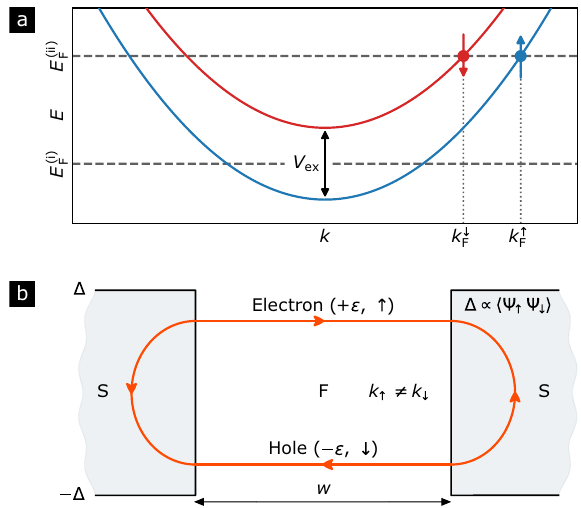
Fig. 2 Bound states in SFS junctions. a Simpli fi ed band structure of a ferromagnet, with the majority and minority bands, split by V ex . k " F and k # are the Fermi momenta for the majority and minority carriers, F respectively. Fermi level E ð i Þ corresponds to large V ex , where the F minority band is pushed above E ð i Þ . E ð ii Þ corresponds to small V ex . F F Thus, the propagation of minority quasiparticles is characterized by and is suppressed. b Supercurrent in an imaginary momentum k # F SFS junction is carried by Andreev bound states localized in the junction. Solid red line represents a quasi-classical trajectory corresponding to an Andreev bound state. The spectrum of Andreev states depends on the relative superconducting phase difference (cid:3) k # j w , across the junction as well as the phase, δφ ¼ j k " F F accumulated due to the difference of Fermi momenta for the majority and minority carriers. Note that in scenario (i) the propagation of minority carriers is suppressed leading to an overall exponential decay of the supercurrent with w . This is to be contrasted with the normal transport through the